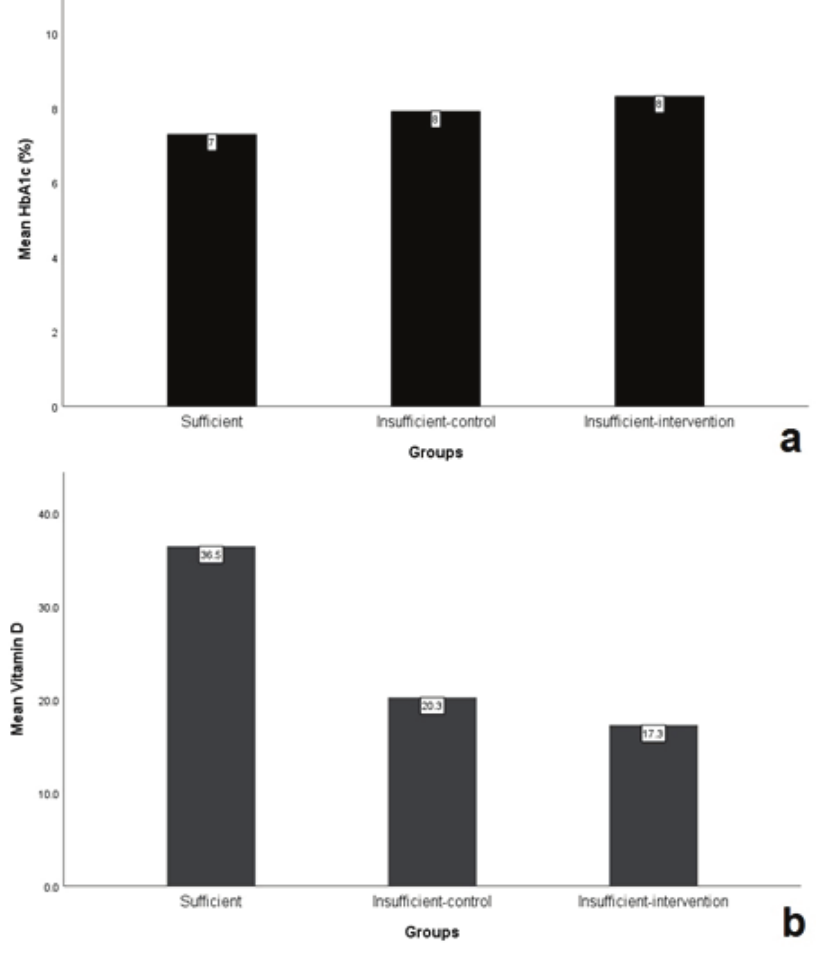
Figure 1. The mean HbA1c (a) and vitamin D levels (b) in different study groups.